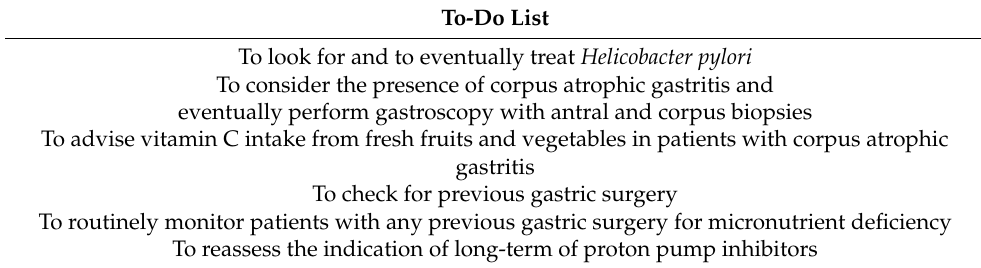
Table 2. Suggestions of a To-Do List to check patients with micronutrient deficiencies such as iron, cobalamin, calcium, magnesium, and/or ascorbic acid. To-Do List To look for and to eventually treat Helicobacter pylori To consider the presence of corpus atrophic gastritis and eventually perform gastroscopy with antral and corpus biopsies To advise vitamin C intake from fresh fruits and vegetables in patients with corpus atrophic gastritis To check for previous gastric surgery To routinely monitor patients with any previous gastric surgery for micronutrient deficiency To reassess the indication of long-term of proton pump